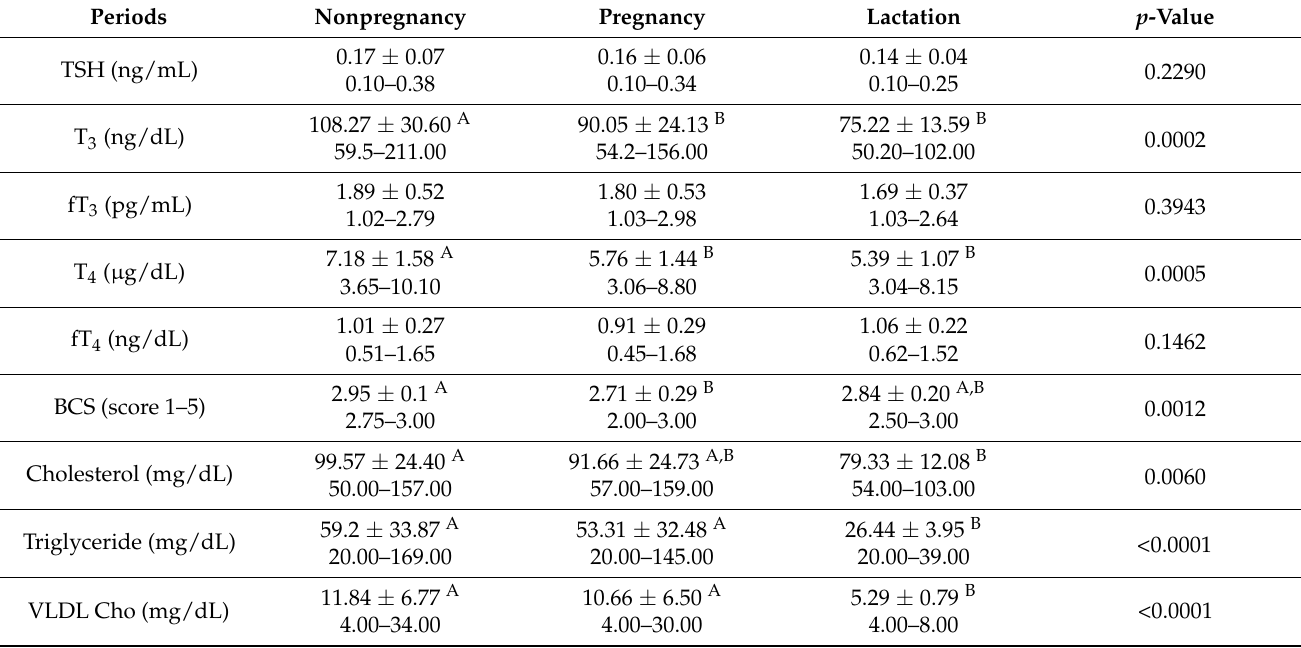
Table 1. Circulating thyroid-stimulating hormone (TSH), total and free triiodothyronine (T 3 , fT 3 ), total and free thyroxine (T 4 , fT 4 ) concentrations, body condition score (BCS), and lipidic panels (mean ± sd) and min and max values in different physiological periods of 30 Nicastrese goats. Within each row, different superscript letters indicate significantly different values.